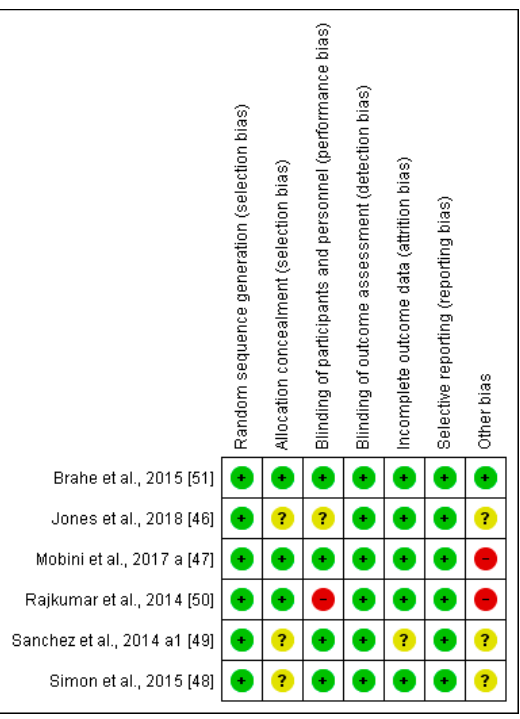
Figure 6. Risk of bias graph of CT: review authors’ judgments about each item as percentages across all included studies.